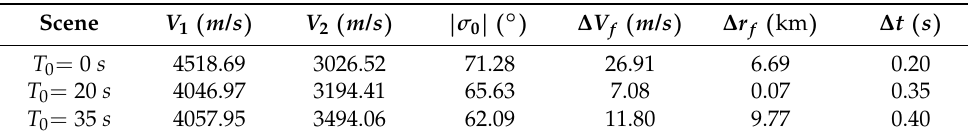
Table 3. Result comparation of the simulations.